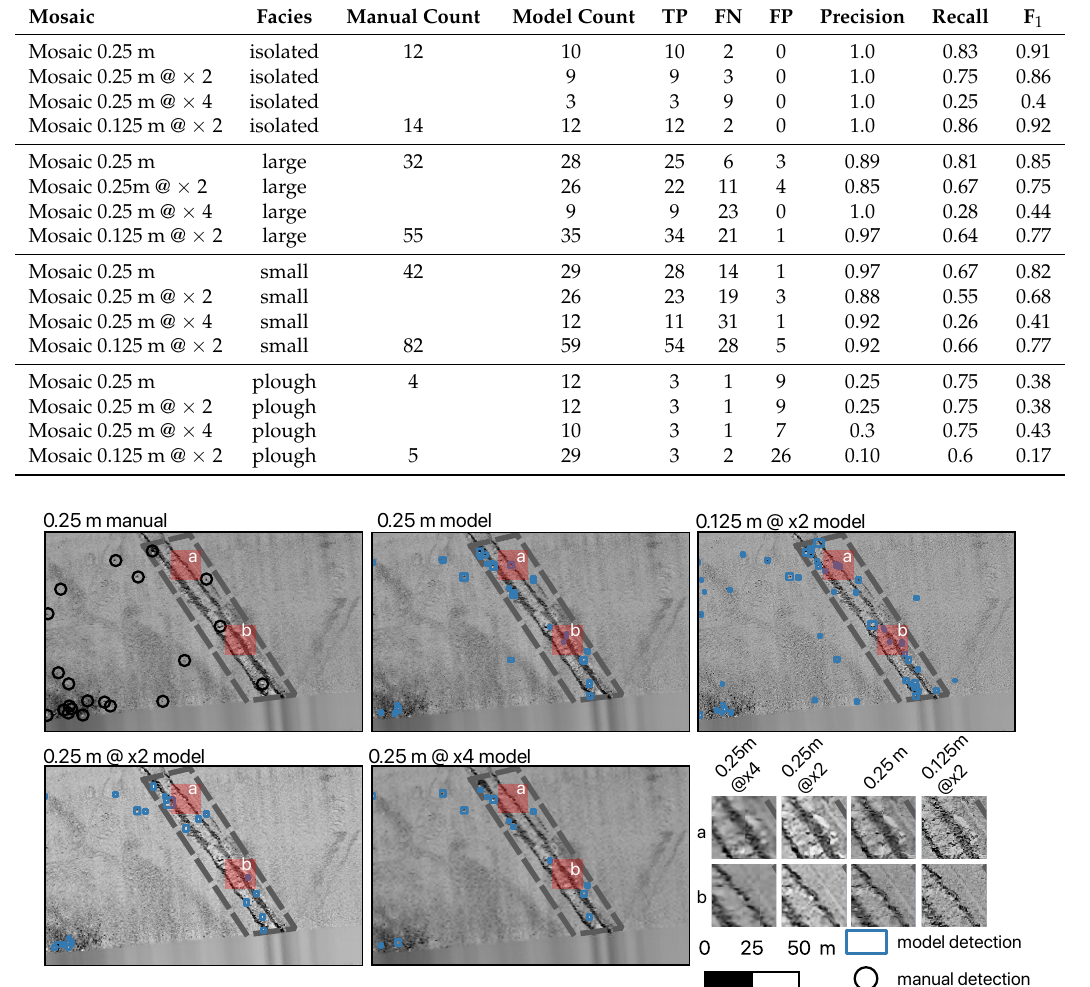
Figure 10. Subsets of the native and upscaled mosaics in an area of plough marks. Manual and model detections are marked. Insets detail the appearance of the plough mark boundaries in the different mosaics. The location of the shown mosaic subset in the validation mosaic is marked in Figure